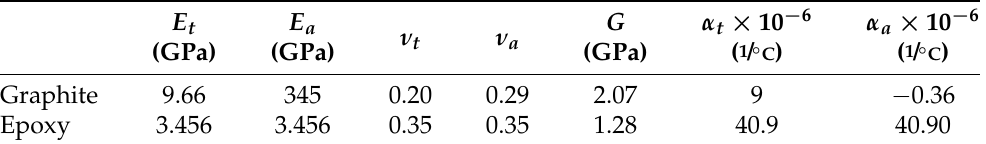
Table 3. Elastic and thermal constants of the fiber and the matrix of the Graphite/Epoxy composite